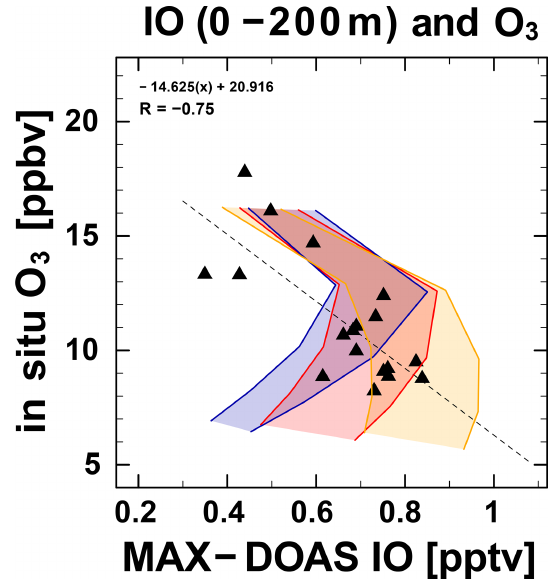
Figure 3. Daily median IO mixing ratio for 0–200m (pptv) ob- served by MAX–DOAS versus daily median in situ ozone mixing ratio (ppbv). Results of box model simulations with O 3 -dependent (Case 1), quasi-O 3 -dependent (Case 2), and pure O 3 independent (Case 3) emission fluxes of iodine compounds are superimposed re- spectively as blue, red, and orange shaded